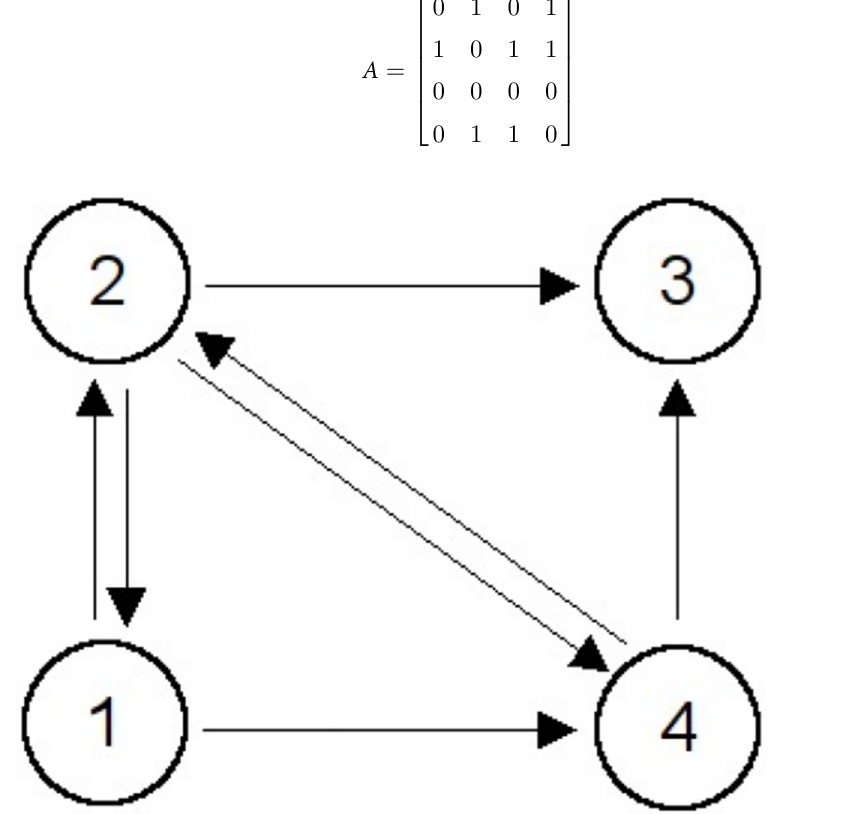
Fig 1. Small web containing just four web